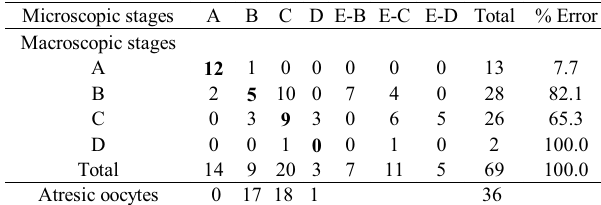
Table 3 . Macroscopic vs . microscopic classification of the ovaries of C. spilopterus collected in the Mamanguá Inlet. Bold = percentages of setting right evaluation of the maturity stages. E-B, E-C and E-D had post-ovulatory follicles but were characterized by other oocytes stages.